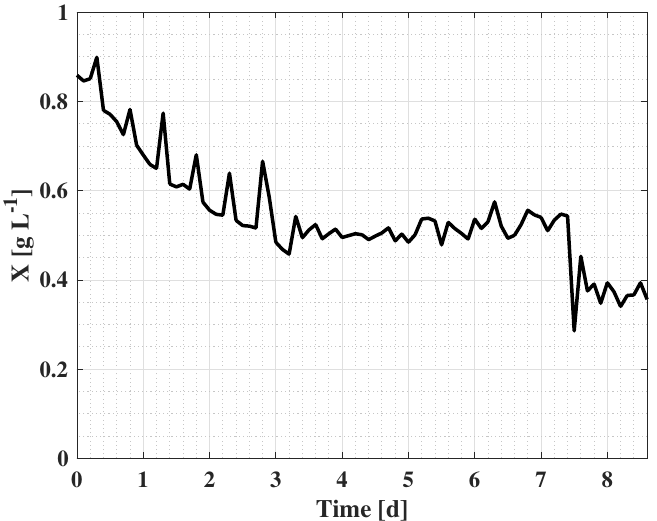
Figure 10. Time evolution of the algal biomass during the experimental validation of the SSC